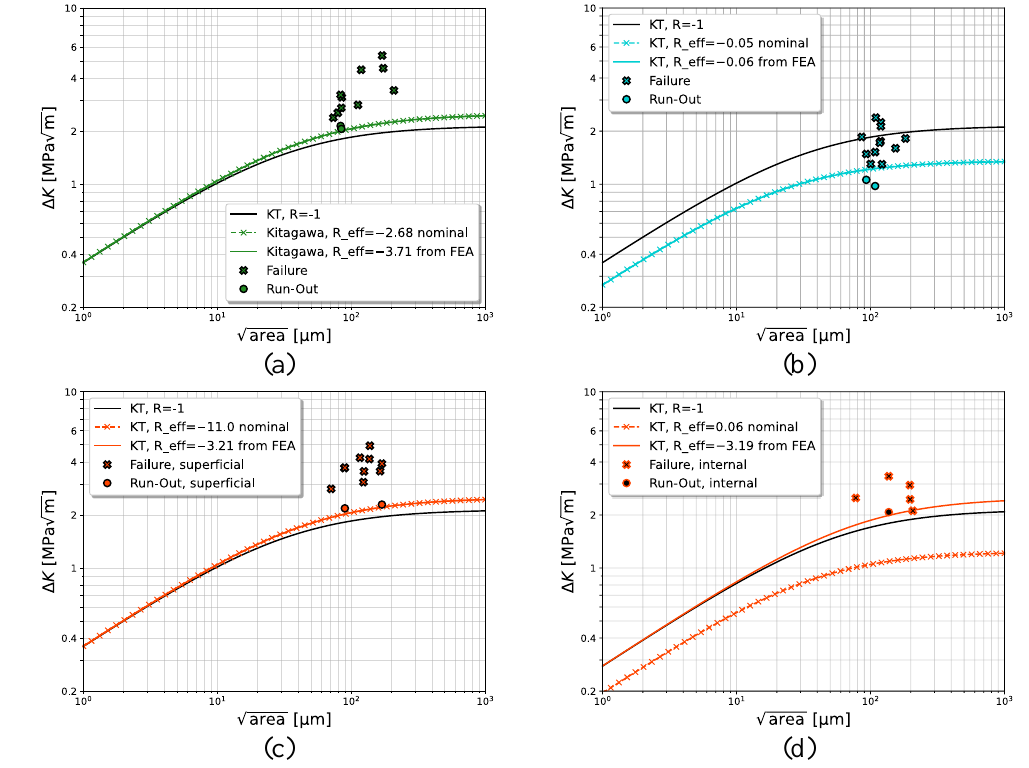
Figure 10. Kitagawa diagrams for the estimation of the fatigue strength against the experimental results of the three tested specimens’ series: ( a ) machined specimens; ( b ) net-shape specimens; ( c ) sandblasted specimens for superficial defects and ( d ) sandblasted specimens for internal